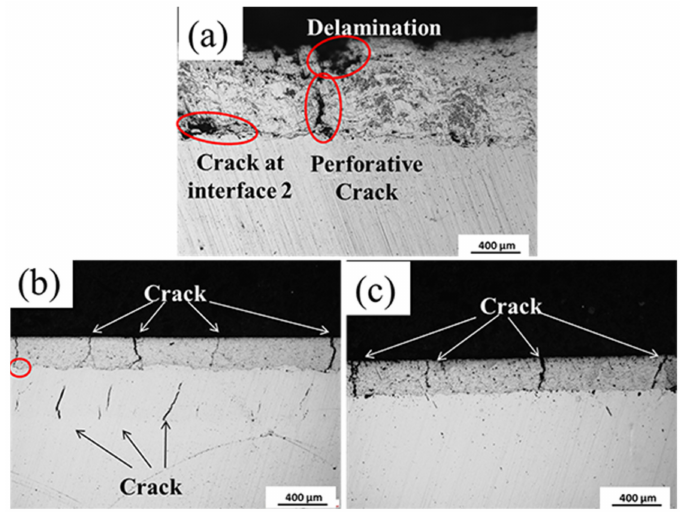
Figure 9. The cross section of the complex coating after BFT: ( a ) No. 1; ( b ) No. 2 and ( c ) No.